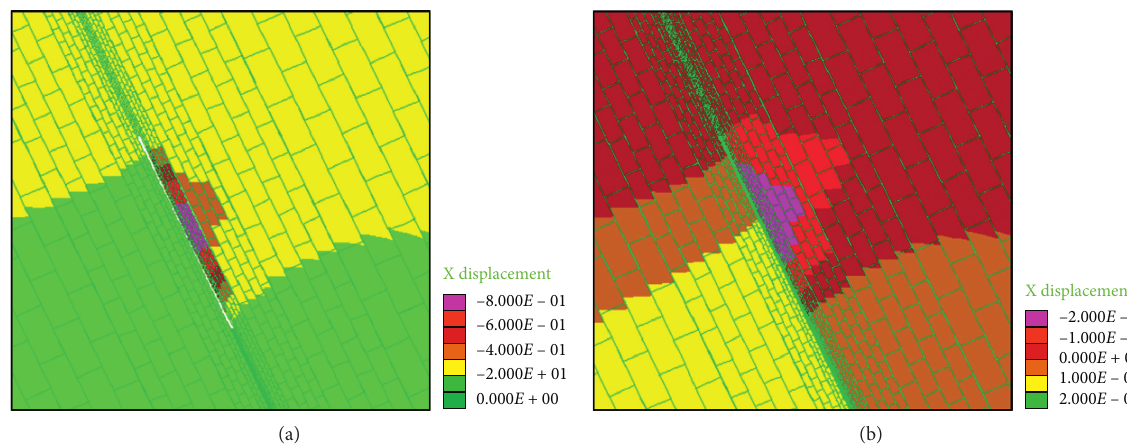
Figure 5: Horizontal displacement contours of surrounding rock with 120m stope height. (a) Caving. (b) Backfilling.